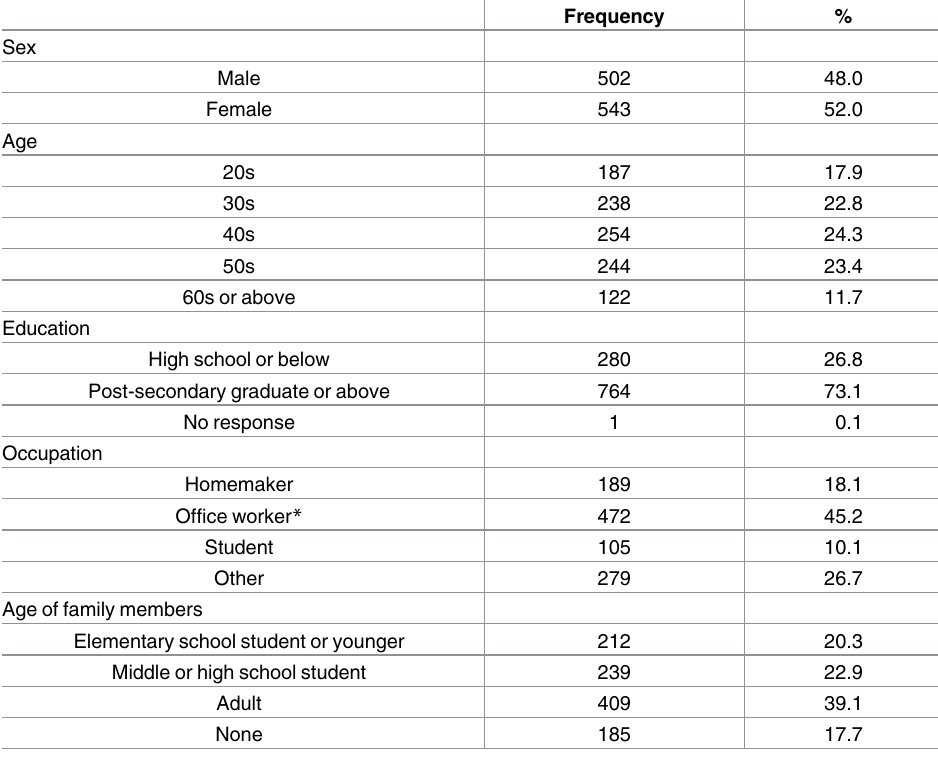
Table 1. Participants’ characteristics.